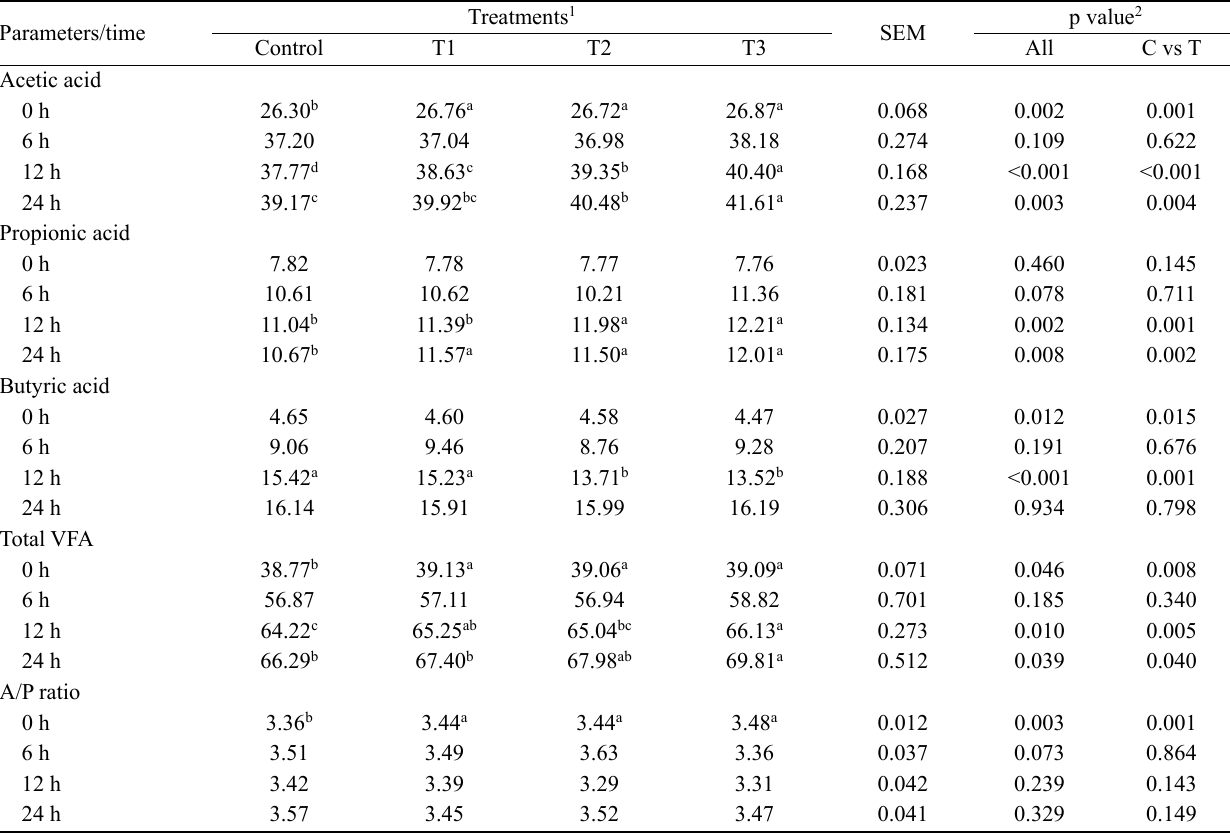
Table 3. Volatile fatty acid (VFA) production (mM) and A/P ratio from in vitro fermentation by the addition of lysozyme